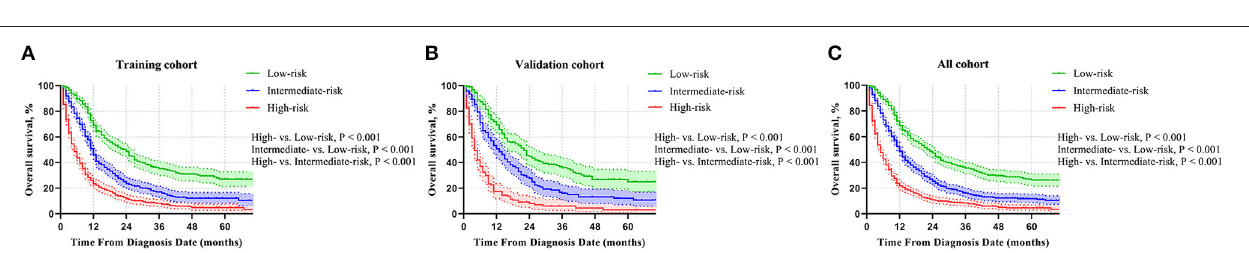
FIGURE 4 | Comparison of OS in the low-risk, intermediate-risk, and high-risk group in the (A) training group, (B) validation group, and (C) all patients.